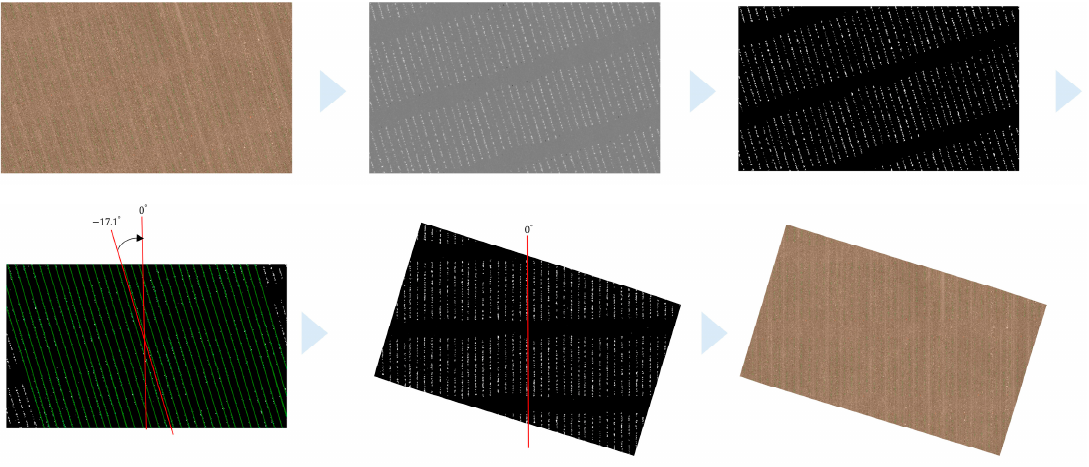
Figure 9. The image alignment process, based on the crop row direction.